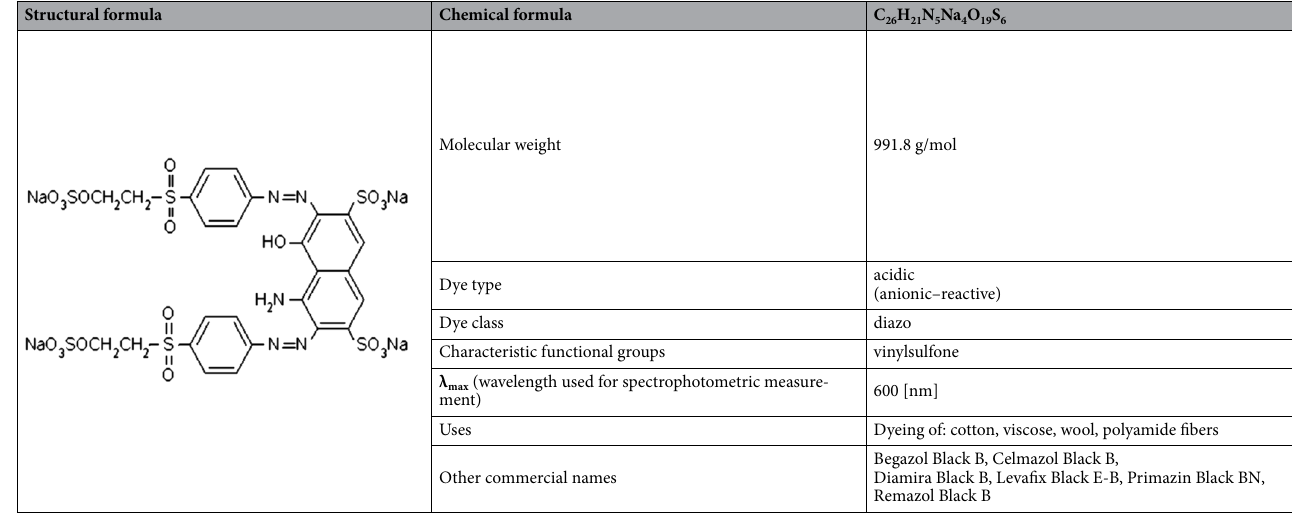
Table 1. Characteristics of RB5.